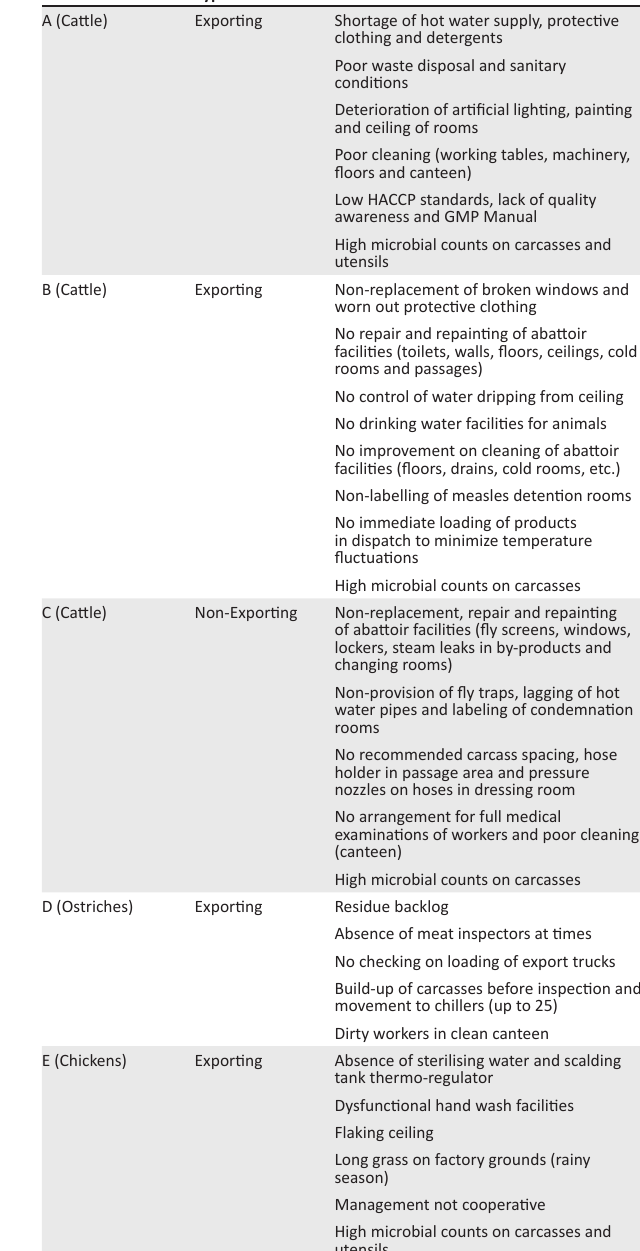
TABLE 3: Shortfalls identified on the analysis of audit and quality communications for the five selected abattoirs for the period January 2002 to December 2007.